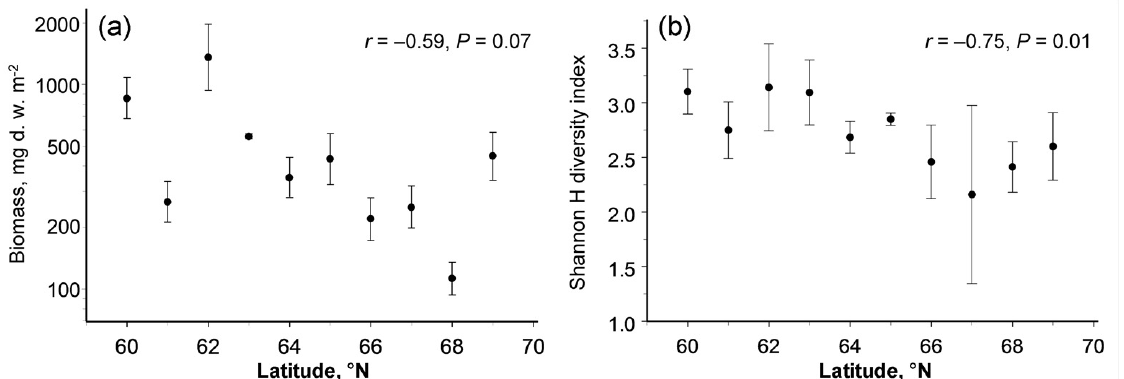
Figure 2. Latitudinal patterns in ( a ) biomass and ( b ) diversity of soil macrofauna (means and 95% confidence intervals, each based on four sampling dates).